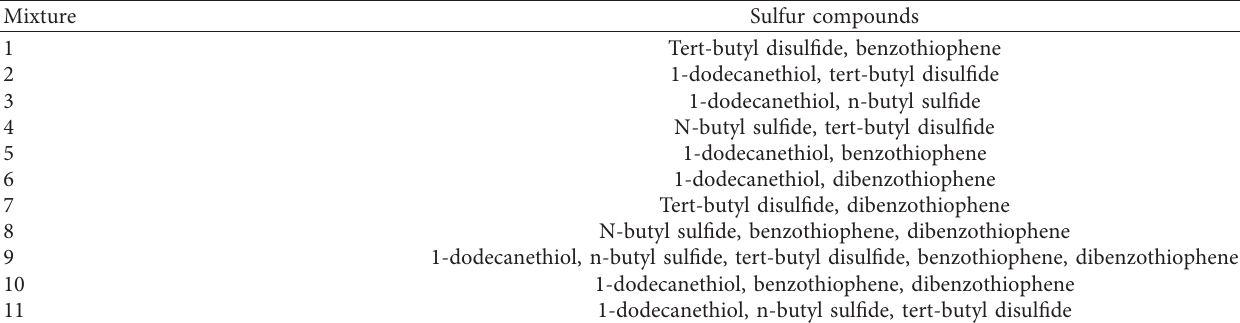
Table 1: Model sulfur compounds contained in the eleven mixtures of surrogate